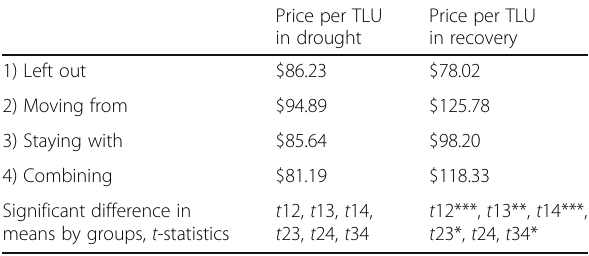
Table 10 Price per TLU in drought and